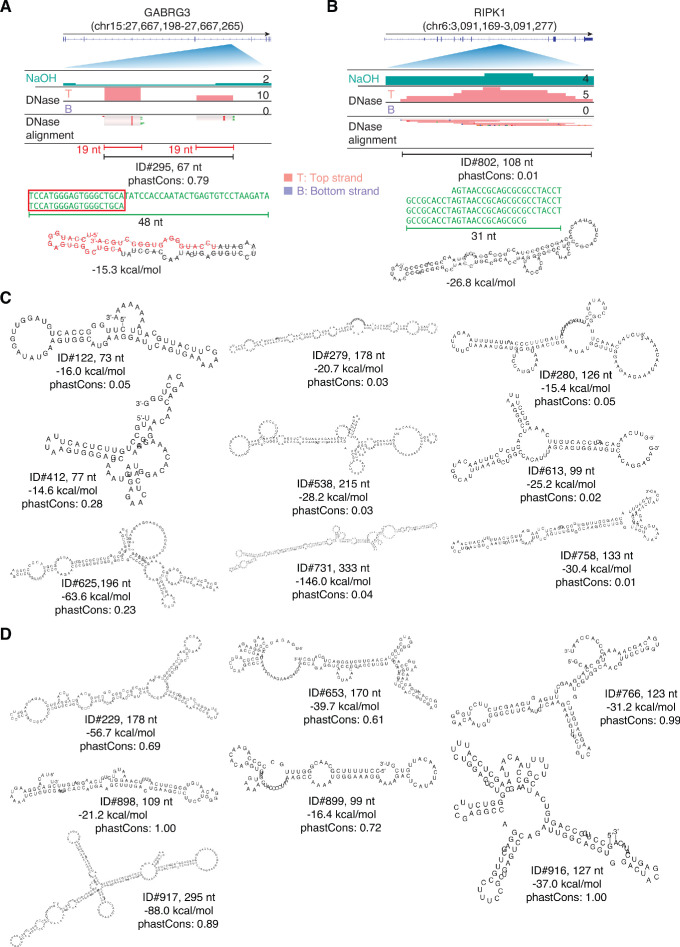
IGV screenshots and predicted secondary structures for peaks corresponding to intron RNA fragments.(A, B) Intron peaks comprised of complex tandem repeats. The predicted stem-loop structure for the peak in panel A includes two 19-nt segments that correspond a 19-nt RNA (red) with reads distributed between the two segments. (C) Most stable RNA secondary structures predicted by RNAfold for peaks corresponding to intron RNA fragments. (D) Most stable RNA secondary structures predicted by RNAfold for peaks mapping to retrotransposed mRNA sequences within long introns. In panels C and D, the length of the peak is indicated next to the peak ID, and the most stable predicted secondary structure and its MFE (ΔG) computed by RNAfold are shown below.